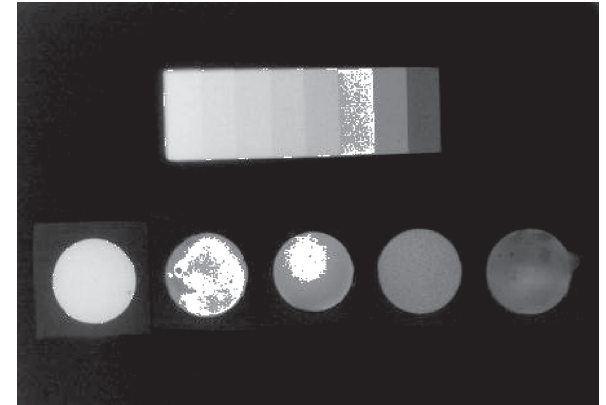
FIGURE 3- Radiograph showing the radiopacity of Endofill and Roeko Seal and their equivalence to the aluminum step wedge